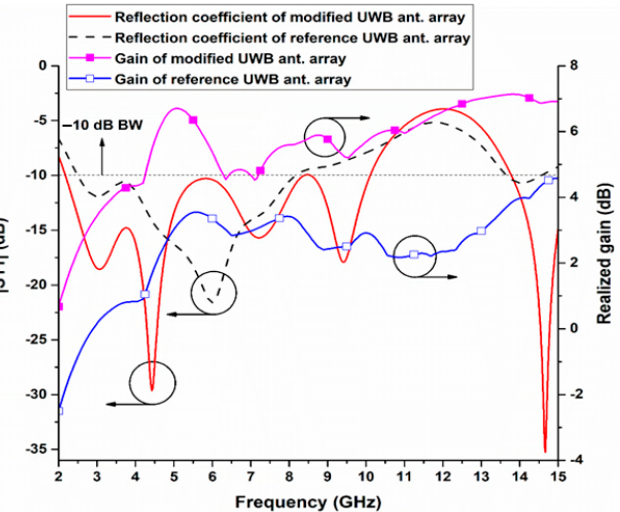
Figure 6. Simulated reflection coefficients and realized gain of the reference and modified UWB antenna array.